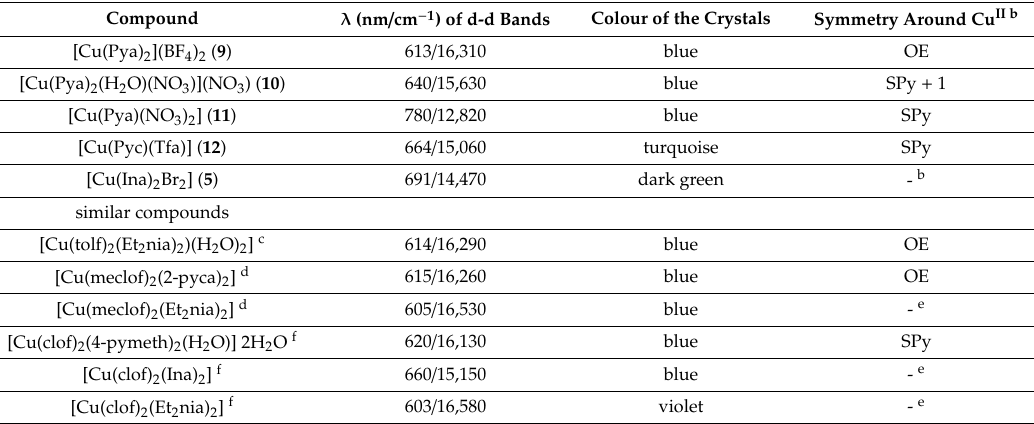
Table 5. UV-vis absorption maxima of selected copper complexes.